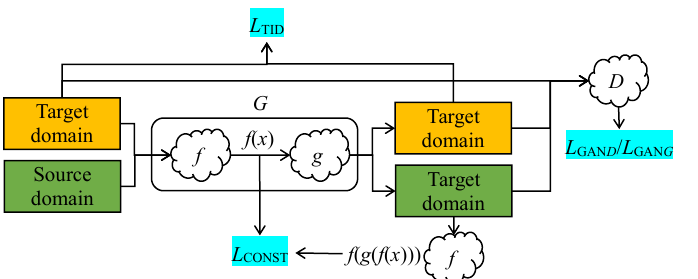
Figure 4. The framework of DTN. The generative network G is composed of feature extractor f and image generative network g , where f will extract the image features of the input image, and g is used to generate the image. As to loss function, L const supervises the difference of features between two domains, L TID supervises the difference between output and input, and L GAN D / L GAN G distinguishes the authenticity of the